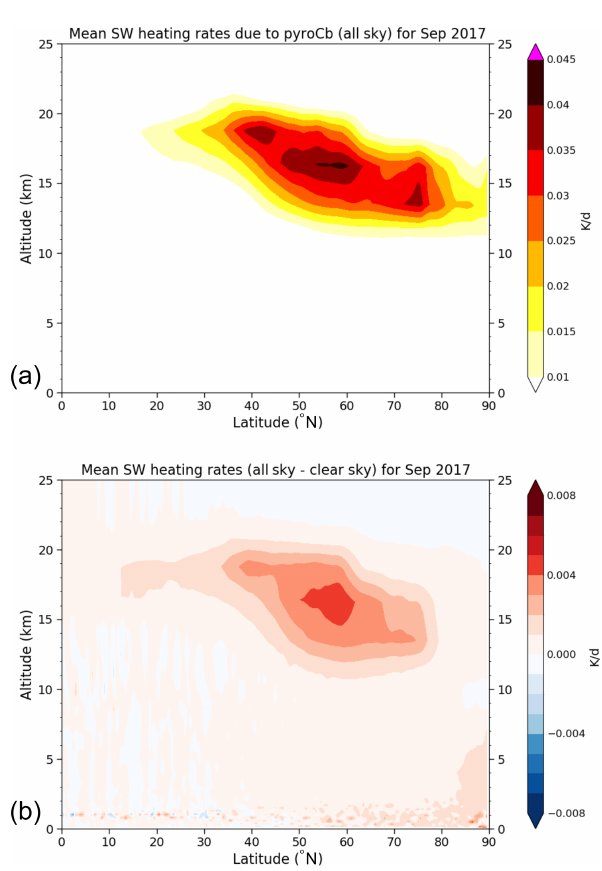
Figure 13. Heating rates. Zonally averaged (a) all-sky and (b) all- sky minus clear-sky shortwave (SW) heating rates for Septem- ber 2017 (K/d) due to the pyroCb aerosols over